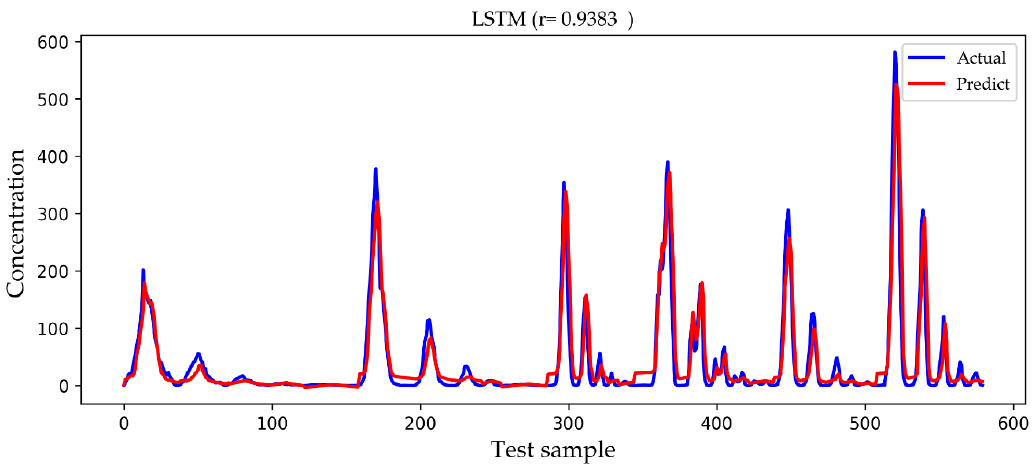
Figure 12. A comparison of the actual and predicted values of the LSTM model. An independent experiment was taken that was close to the average result but not included in the